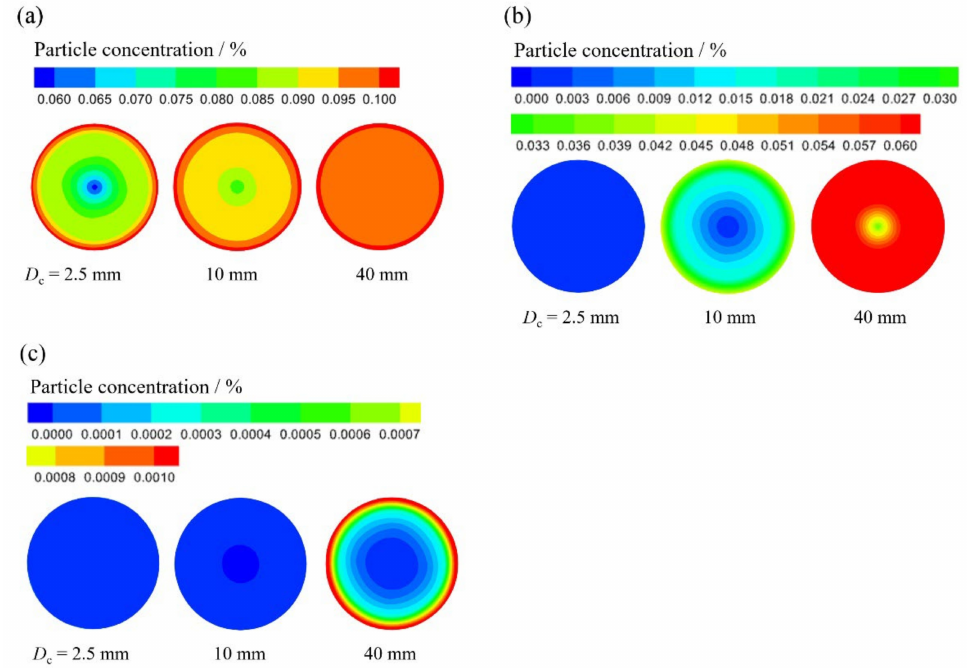
Figure 10. Comparison of particle concentration at overflow outlet of hydrocyclone with different main diameters. ( a ) Particle size d p = 5 µ m; ( b ) d p = 20 µ m; ( c ) d p = 60 µ m.